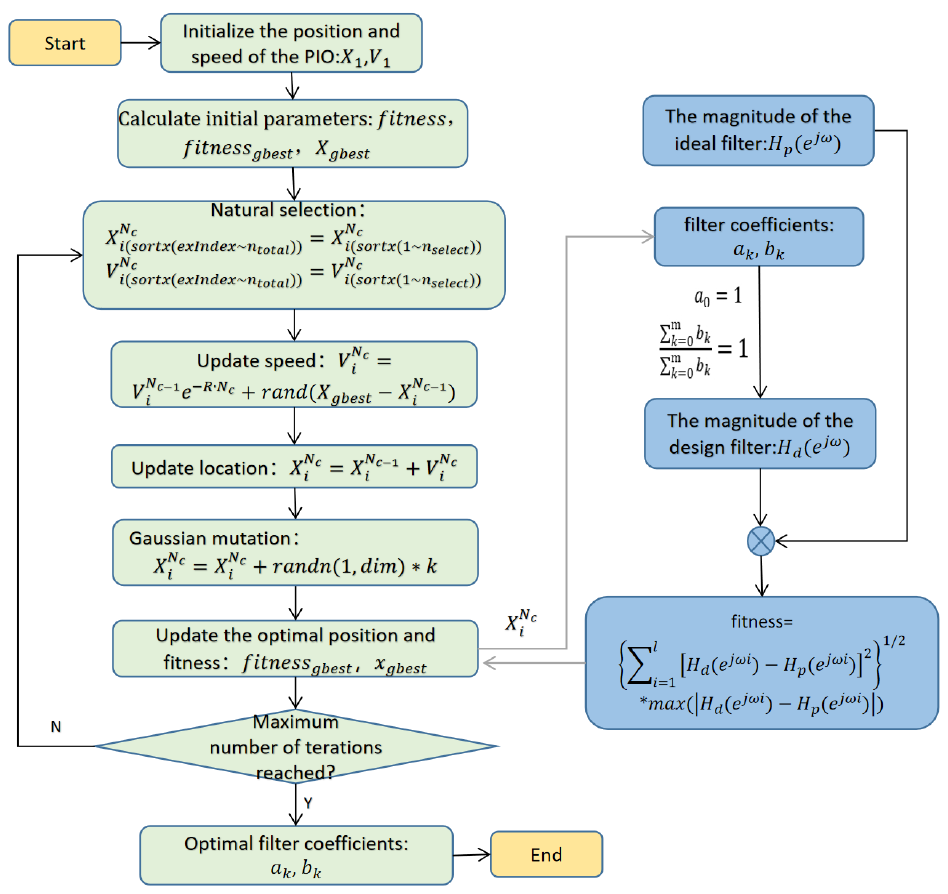
Figure 3. Flow chart of filter design method based on SMPIO.